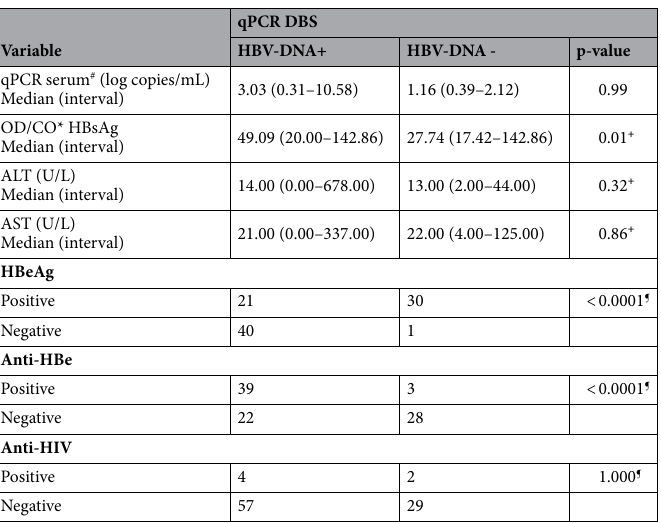
Table 5. HBV DNA quantitative detection in DBS samples by qPCR correlated to laboratory variables. *OD/ CO = optical density/cut-off; + Mann–Whitney test; #HBV-DNA quantified in serum by qPCR; ¶ Fisher test.